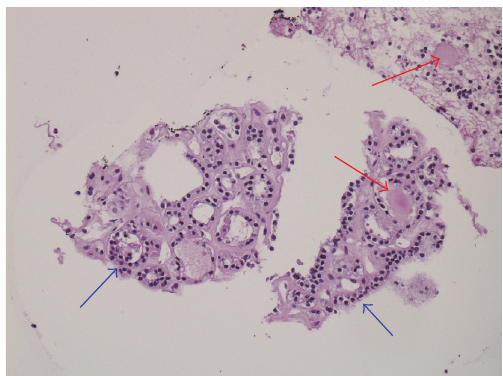
Figure 2: Histological image of ectopic thyroid tissue in medi- astinum. Fragments of benign thyroid tissue identified in the cell block prepared from the transbronchial needle aspiration. Bland, uniform thyroid epithelial cells are disposed in the follicular units characteristic of benign thyroid tissue (blue arrow), with focal pres- enceofintrafollicularcolloid(redarrow).Thereismildperifollicular hyalinization (Hematoxylin and Eosin,